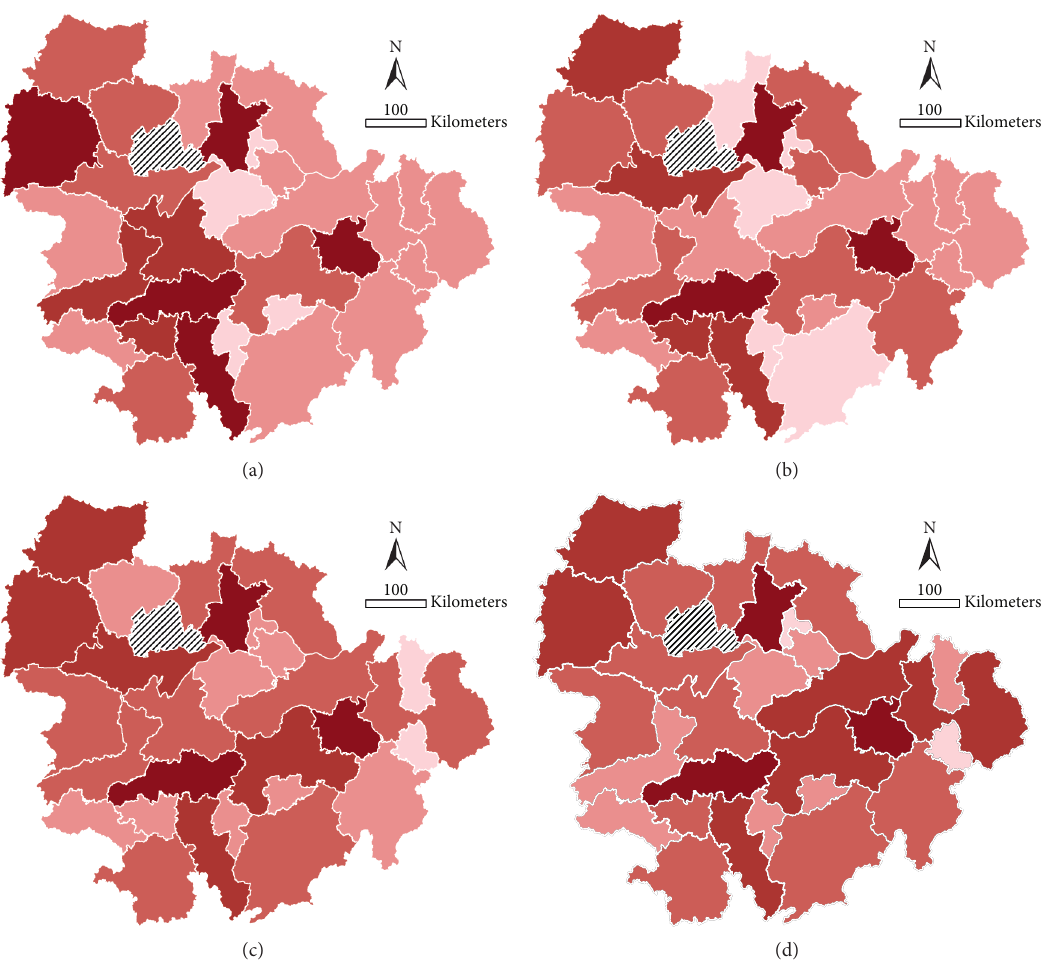
Figure 8: Spatial distribution of urban innovation and entrepreneurship index in (a) 2002, (b) 2007, (c) 2012, and (d)